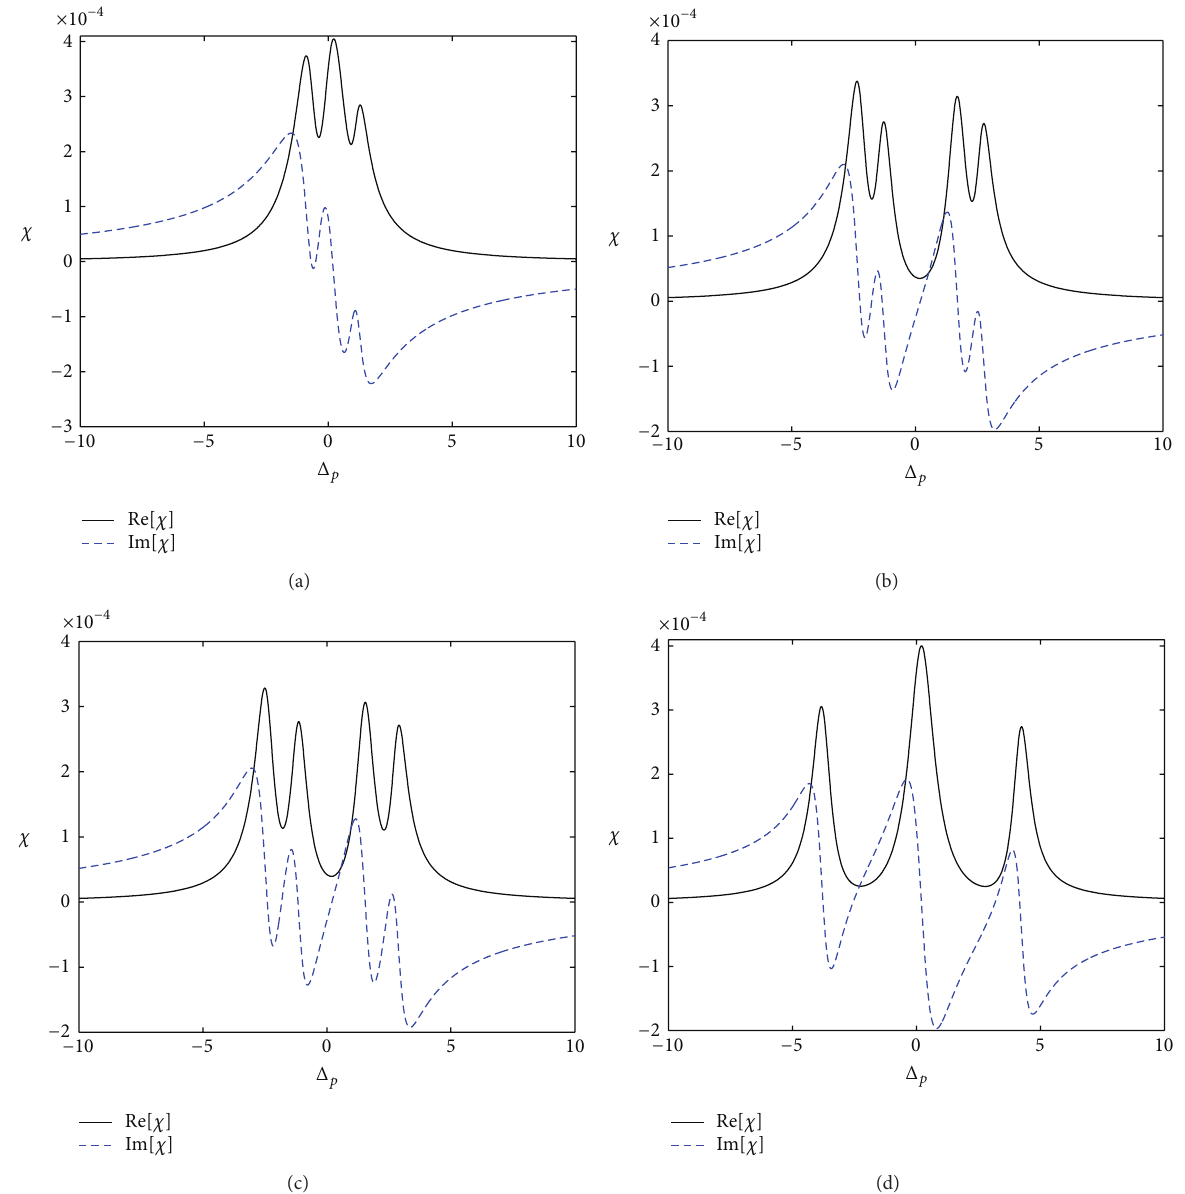
Figure 2: Real and imaginary parts of the linear susceptibility versus probe field detuning. The selected parameters are (a) 𝑇 1 = 𝑇 2 = 0.5 meV; (b) 𝑇 1 = 2 meV, 𝑇 2 = 0.5 meV; (c) 𝑇 1 = 0.5 meV, 𝑇 2 = 2 meV; (d) 𝑇 1 = 𝑇 2 = 2 meV. The other parameters are 𝛾 41 = 𝛾 42 = 𝛾 31 = 𝛾 32 = 0.1 meV, = 5 meV, Γ = 2 meV, Γ = Γ = Γ = 0.5 meV, Γ = 2 meV, 𝛾 = 0.05 meV, 𝜔 = 𝜔 = 0.2 meV, and Λ = 0 , Ω Γ 12 31 41 42 32 43 12 21 34